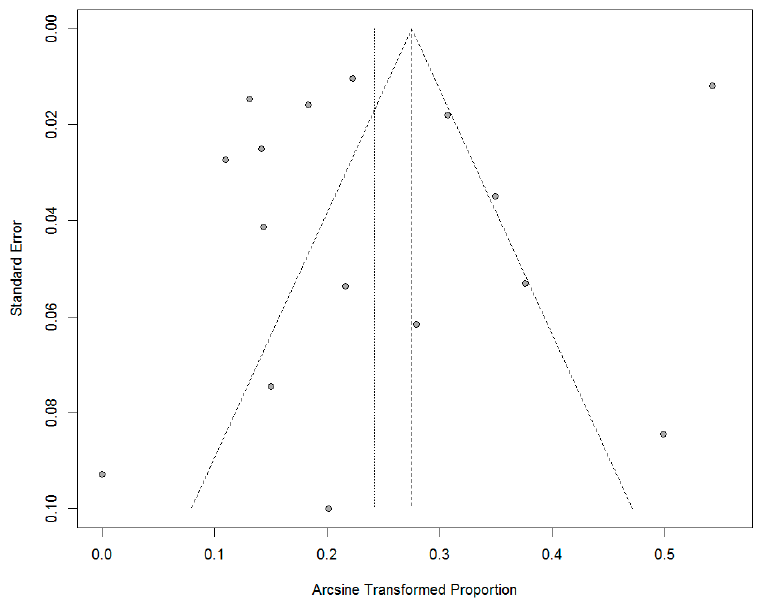
Figure 5. Funnel plot of the standards errors on the y -axis plotted against the arcsine of the pro- portion on the x -axis. This indicates a broadly symmetrical distribution of studies which suggests a low level of publication bias—there is some study heterogeneity.